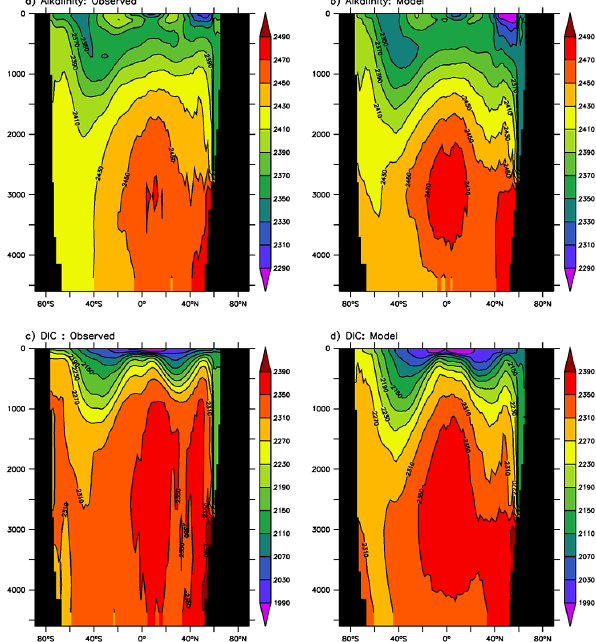
Figure A1. Comparison of the observed alkalinity (a) and prein- dustrial dissolved inorganic carbon (c) (Key et al., 2004) with the REF simulation in the year 1850 for alkalinity (b) and dissolved inorganic carbon (d) in units of mmolm − 3